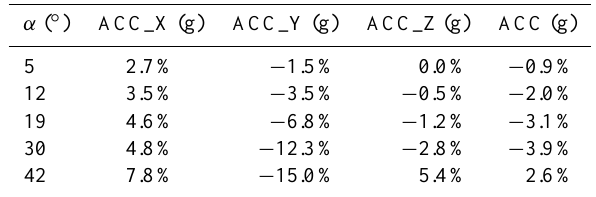
Table 9. Relative error between experimental 1 and theoretical val- ues of α for different α